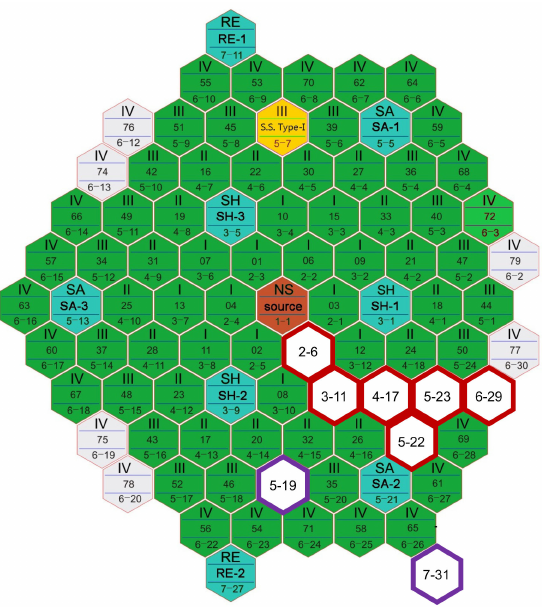
Figure 15. Positions and subassembly loading for swap-reactivity measurement. (Red color: fuel subassemblies; Purple color: type-I SS